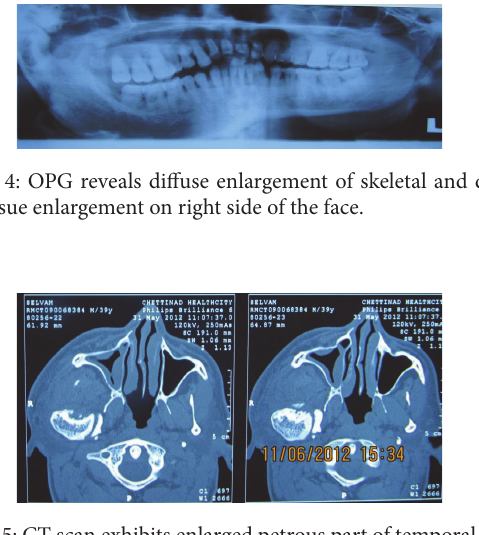
Figure 5: CT scan exhibits enlarged petrous part of temporal bone, pituitary fossa, maxilla, and mandible.